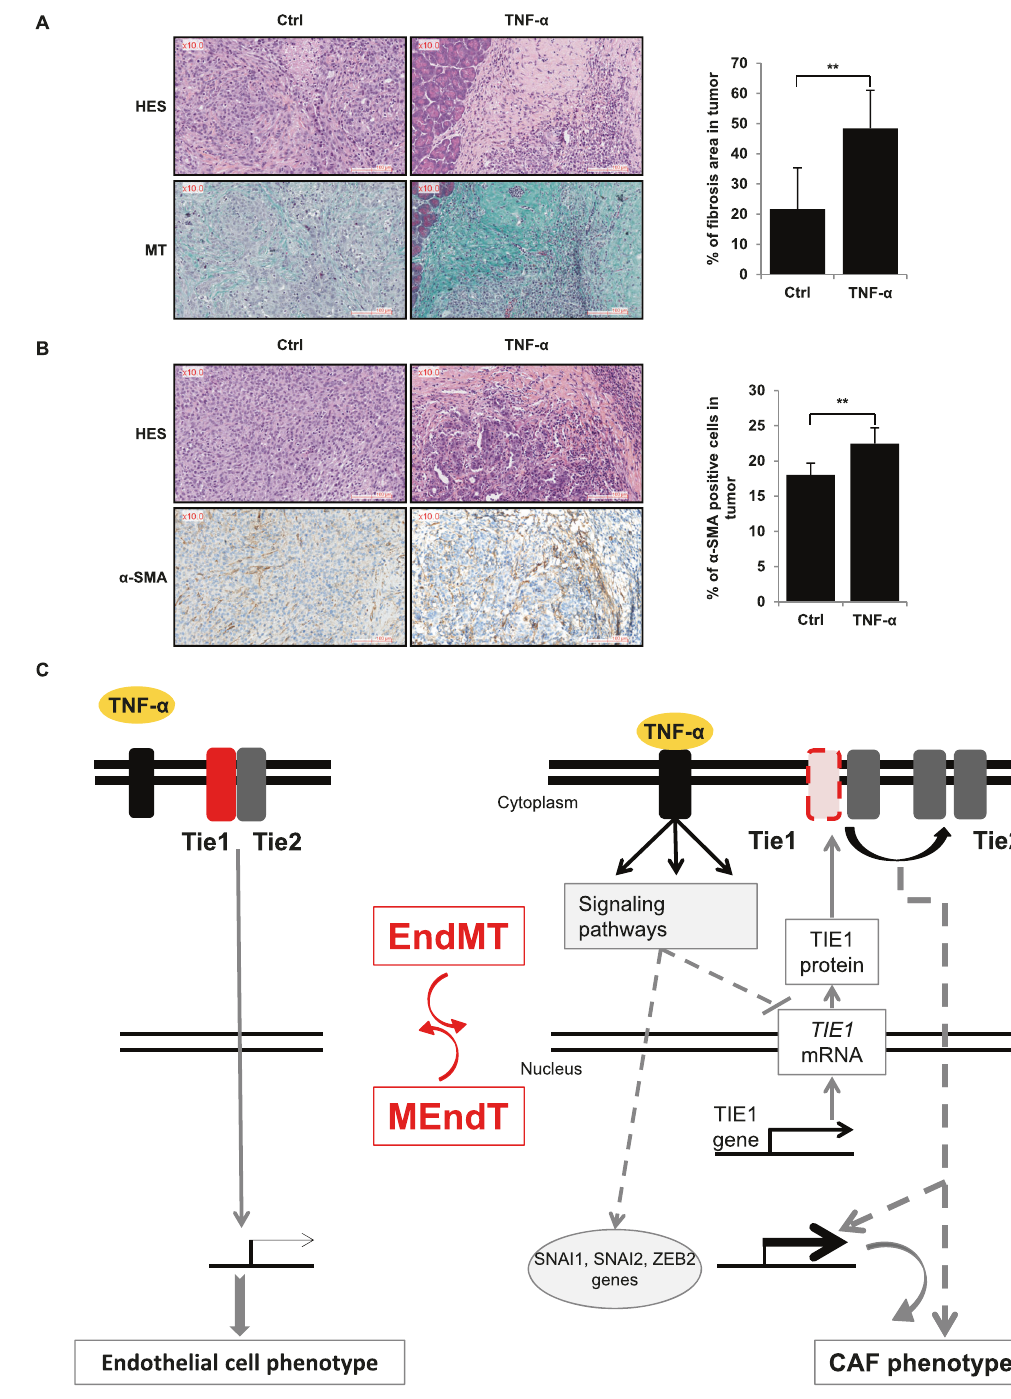
Fig. 7 In vivo effect of TNF- α and schematic model of its action. TNF- α increases CAFs in pancreatic tumour in vivo ( A , B ) and schematic model of the reversible TNF- α -induced EndMT involving Tie1 downregulation ( C ). A , B . TNF- α induces an increase of fi brosis ( A ) and an increase of CAFs α -SMA positives ( B ). PK4A tumoral cells were orthotopically injected in mice which were treated daily for 27 days with injections of NaCl (Ctrl) or TNF- α ( n = 6 for each condition). Then, pancreases were collected and sections of tissue were subjected to HES staining, Masson ’ s trichrome (MT) staining and α -SMA staining. Fibrosis and α -SMA staining were analysed and quanti fi ed by calopix. Signi fi cant differences are indicated by solid lines (** P < 0.05, by t test). Scale bars, 100 µm. CAF cancer-associated fi broblast, TNF- α tumour necrosis factor- α , Ctrl control, HES haematoxylin eosin saffron, MT Masson ’ s trichrome MT, α -SMA α -smooth muscle TNF- α by anti-TNF- α antibodies reduces both growth of PDAC tumours in PDX model and the number of pancreatic stellate cells (PSCs) as well as the amount of collagen [56, 57], indicating the possible effects of anti-TNF- α on PDAC-induced desmoplasia.